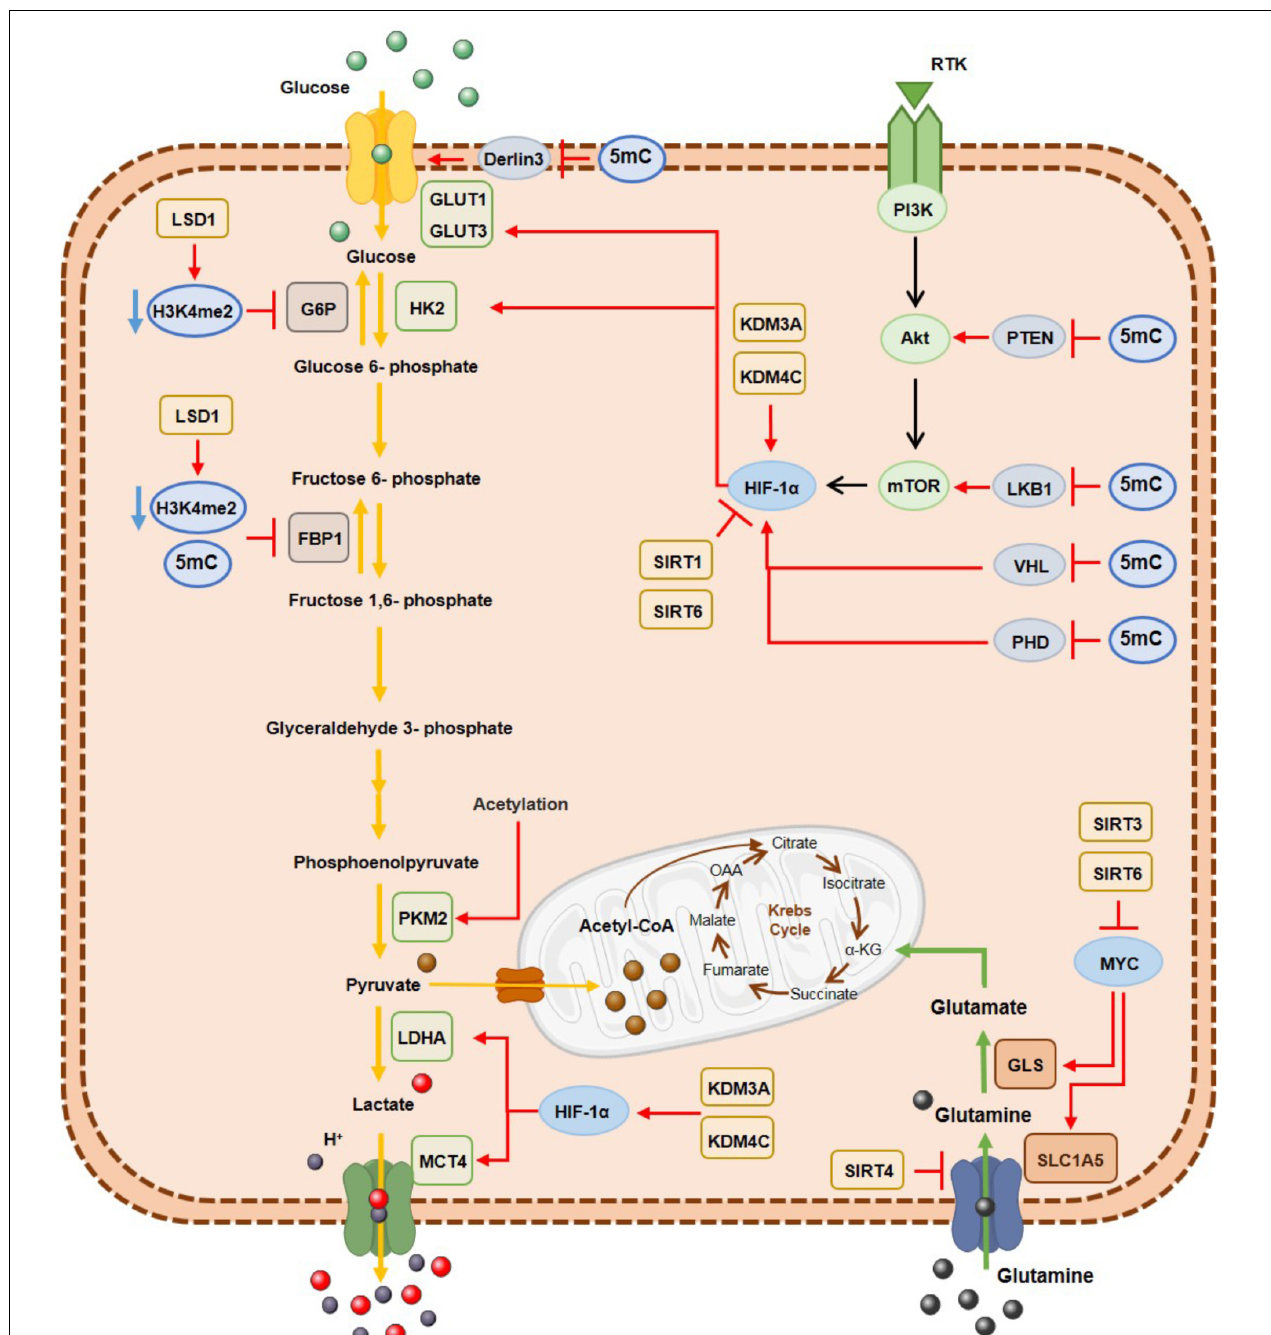
FIGURE 3 | DNA hypermethylation, histone demethylases and histone deacetylases effect on the metabolic enzymes expression involved in glycolysis and glutaminolysis. Epigenetic mechanisms are associated with a metabolic cancer cell reprogramming by transcriptional repression of gluconeogenic enzymes and consequently activation of glycolytic pathway and glutaminolysis, where myc and HIF-1 α transcription factors are important modulators. G6P, glucose 6-phospatase; GLS, glutaminase; GLUT1, glucose transporter 1; GLUT3, glucose transporter3; FBP1, fructose 1,6-biphosphatase; HK2, hexokinase2; LDHA; lactate dehydrogenase A; MCT4, monocarboxylate transporter 4; PKM2, pyruvate kinase M2; SLC1A5, glutamine transporter